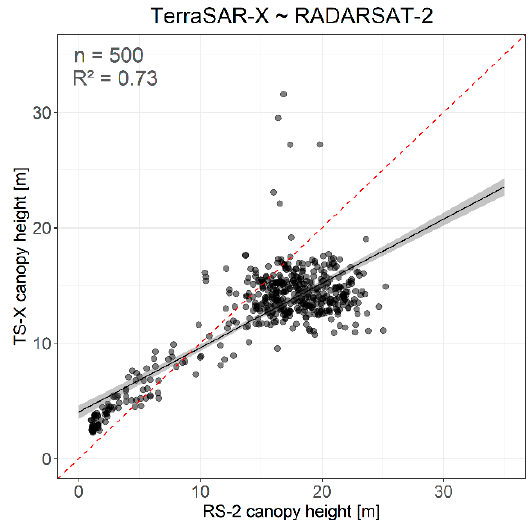
Figure 7. Correlation of modelled TS-X (06.09.–17.09.) canopy height and modelled RS-2 (03.09.–27.09.) canopy height based on the RMoG model. Red dashed line = 1:1 line; black line = linear trend including confidence bounds.